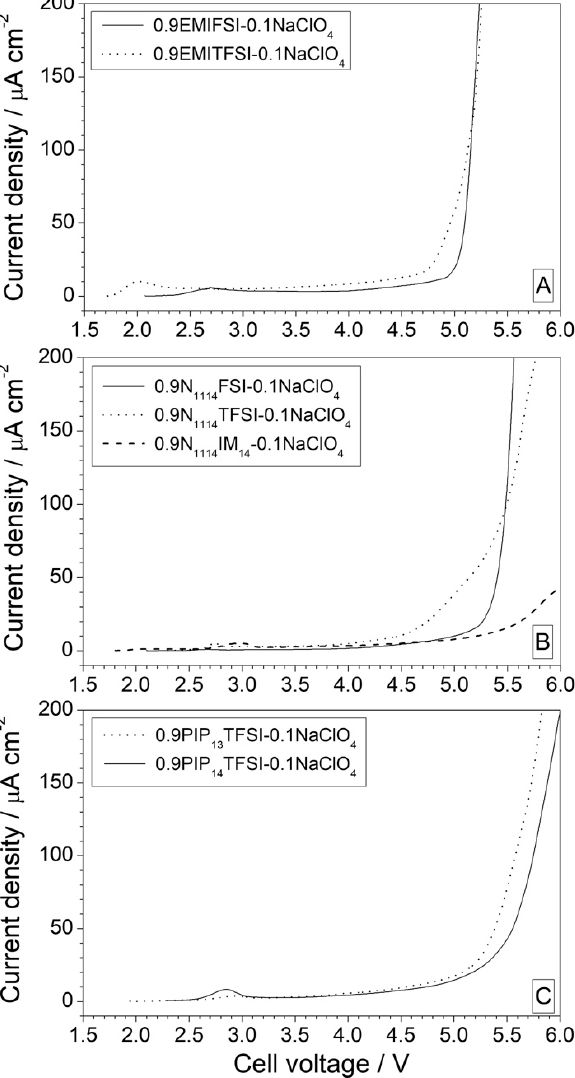
Figure 1. Current-voltage traces obtained through LSV tests run on Na/Pt cells containing EMI (panel ( A )), N 1114 + (panel ( B )) and PIP 1A + (panel ( C )) electrolytes. Ionic liquid: LiClO 4 mole ratio = 9:1. Scan rate: 1 mV s − 1 . Temperature: 20 ◦ C. The voltage values are referred to the Na + /Na ◦ redox couple.